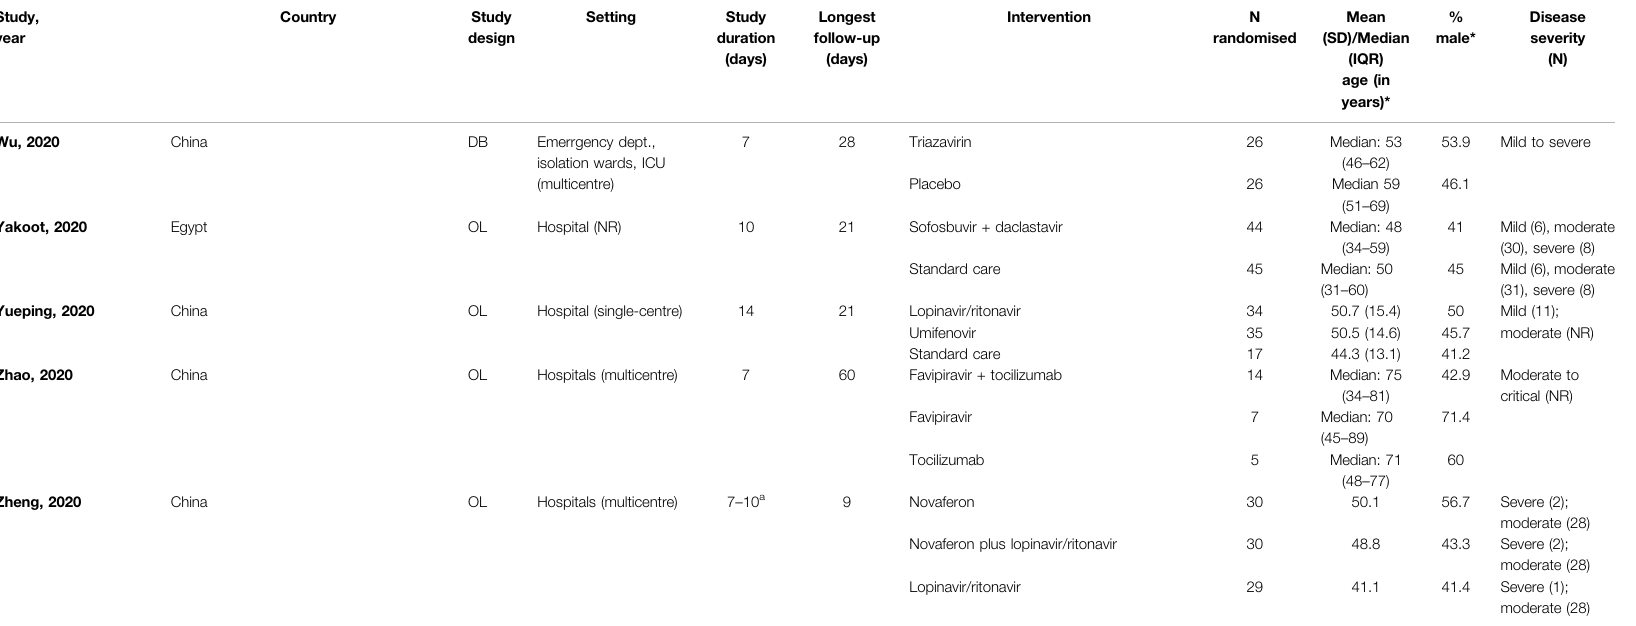
TABLE 1 | ( Continued ) Characteristics of included randomized controlled